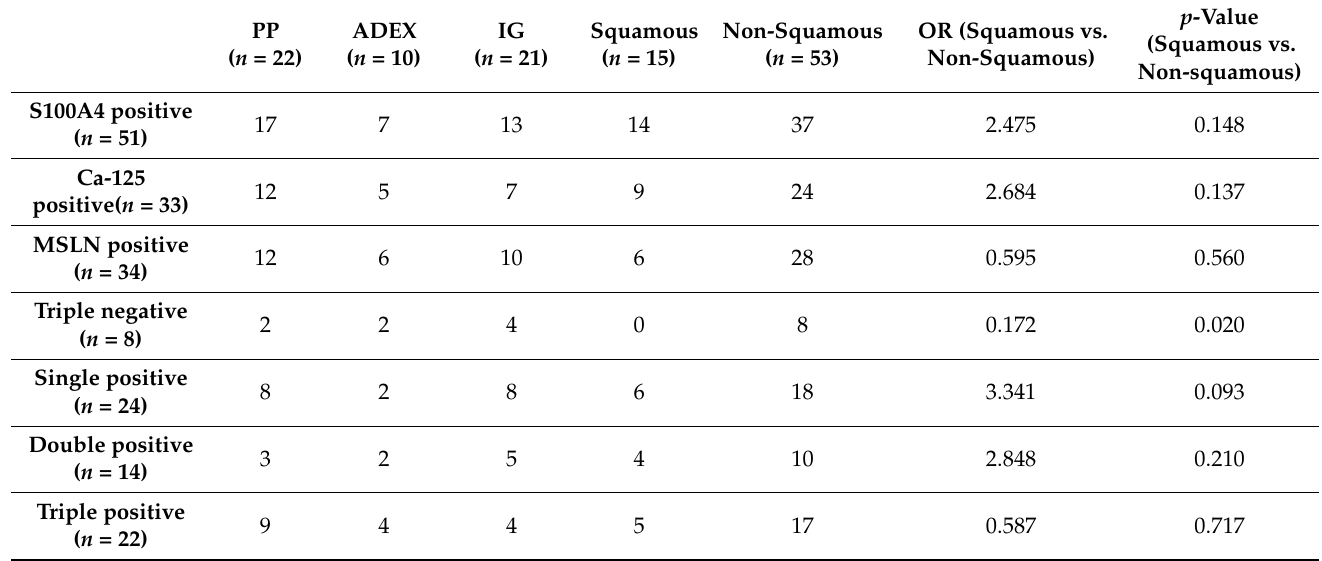
Table 3. Patterns of biomarker expression compared with transcriptomic subtypes of pancreatic